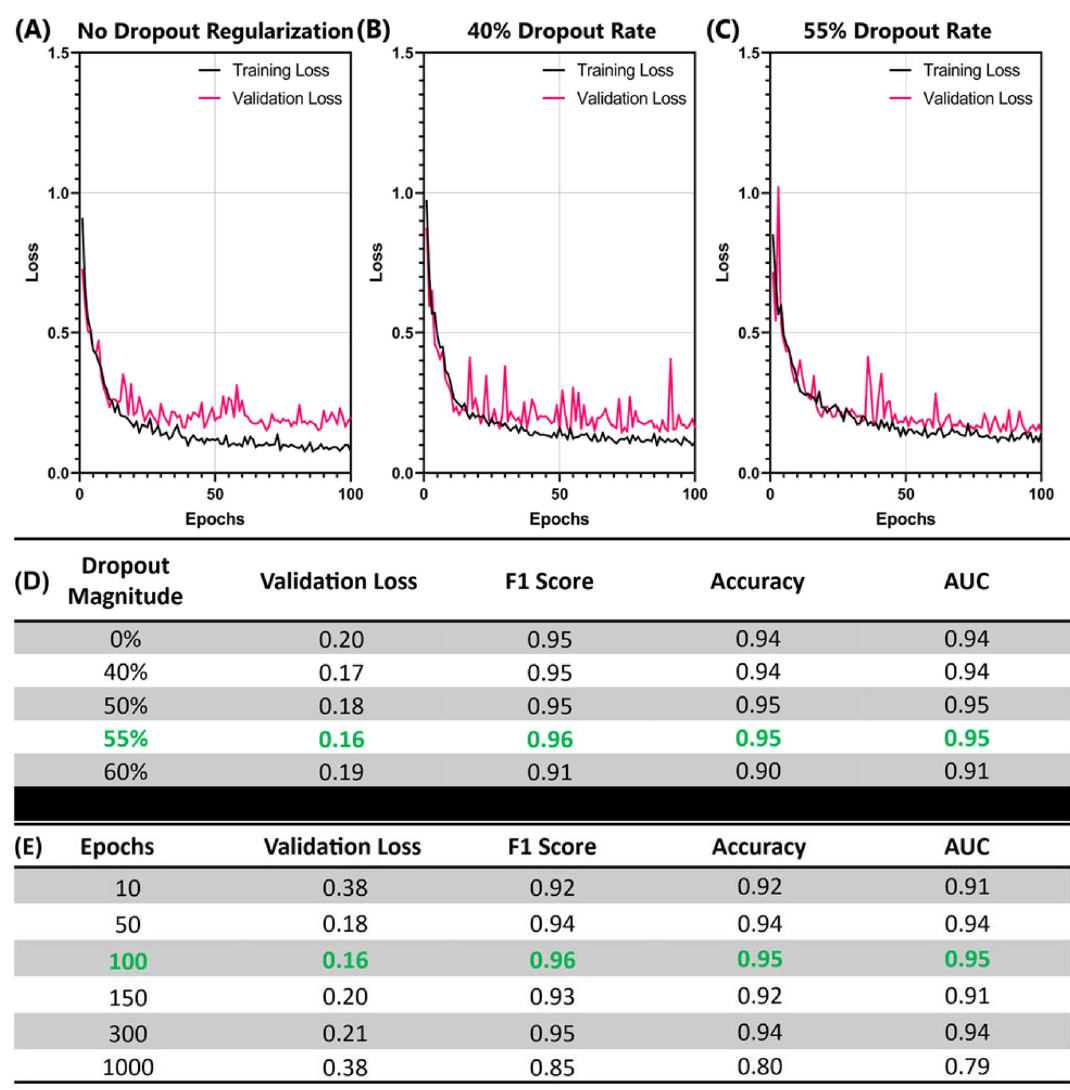
Figure 3. Effect of dropout regularization and number of epochs on model performance. ( A–C ) Training and validation loss plots for models with ( A ) no dropout regularization, ( B ) 40% dropout and ( C ) 55% dropout for the 100 epochs. ( D, E ) Summary of performance statistics for the different magnitudes of ( D ) dropout regularization and ( E ) number of epochs. Performance is shown for average validation loss for the last 5 epochs and F1 score from the test phantom images. Green text font represents the selected model architecture for subsequent optimization